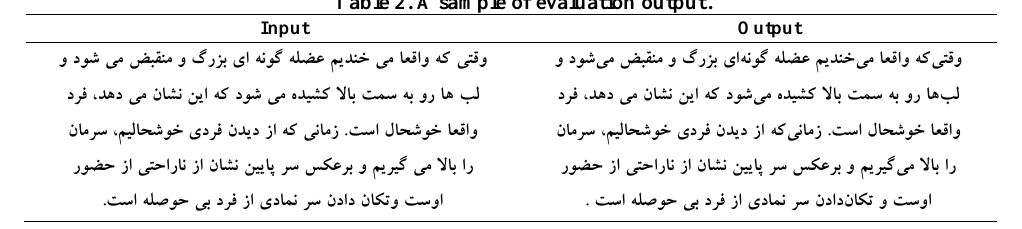
Table 3. Evaluation in the case of increasing the frequency of words with the same structure in the training